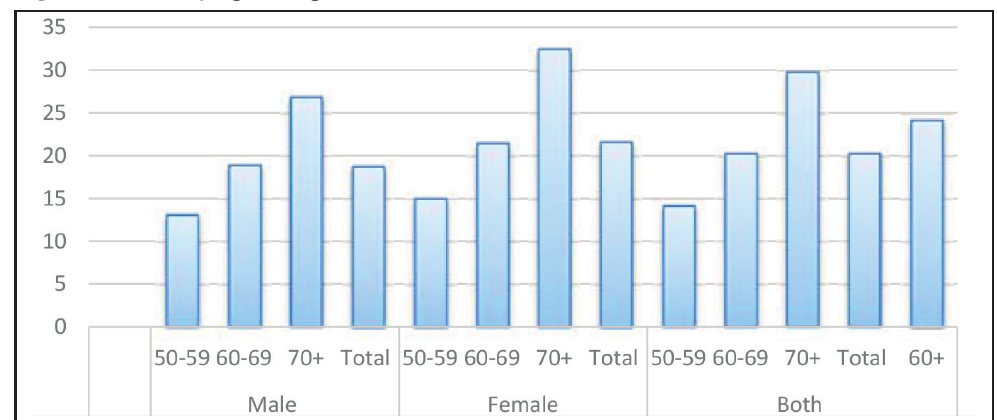
Figure 3 SRH by age and gender in India (LASI-2017-18).